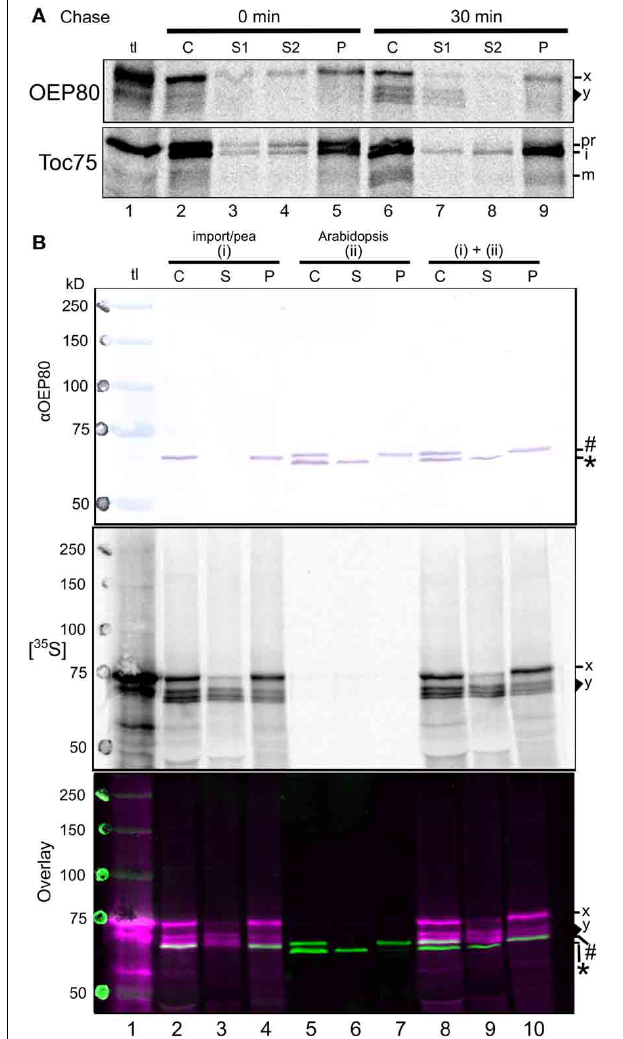
FIGURE 6 | Processing of OEP80 during chloroplast import in vitro . (A) After 10-min incubation with radiolabeled precursors in the import condition in the dark, pea chloroplasts were re-isolated through a Percoll cushion and divided into two samples. The first sample was immediately lysed and separated into soluble (S1), peripheral membrane (S2), and integral membrane (P) fractions as described in the legend to Figure 4A . The second sample was resuspended in import buffer containing 3mM MgATP for 30min at room temperature in the light then separated into the three fractions. The OEP80 precursor of 74kD and imported products ranging from 66–71kD are labeled as x and y; precursor, intermediate and mature forms of Toc75 are indicated with pr, i, and m, respectively. (B) Intact chloroplasts isolated from pea seedlings and incubated with radiolabeled OEP80 in the import condition for 30min in light (i) or chloroplasts isolated from A. thaliana seedlings (ii) were analyzed directly (C) or lysed hypotonically and separated into soluble (S) and pellet (P) fractions by centrifugation. Proteins in each fraction were separated by SDS-PAGE and transferred to a PVDF membrane. The membrane was incubated with the partially-purified anti-OEP80 antibody and the immunoreactions were visualized by colorimetric assay using alkaline phosphatase ( α OEP80), and the radiolabeled proteins in the membrane were visualized by phosphorimager analysis ([ 35 S]). The two images were overlaid using ink spots and radiolabeled marking spots (Overlay). In Overlay,